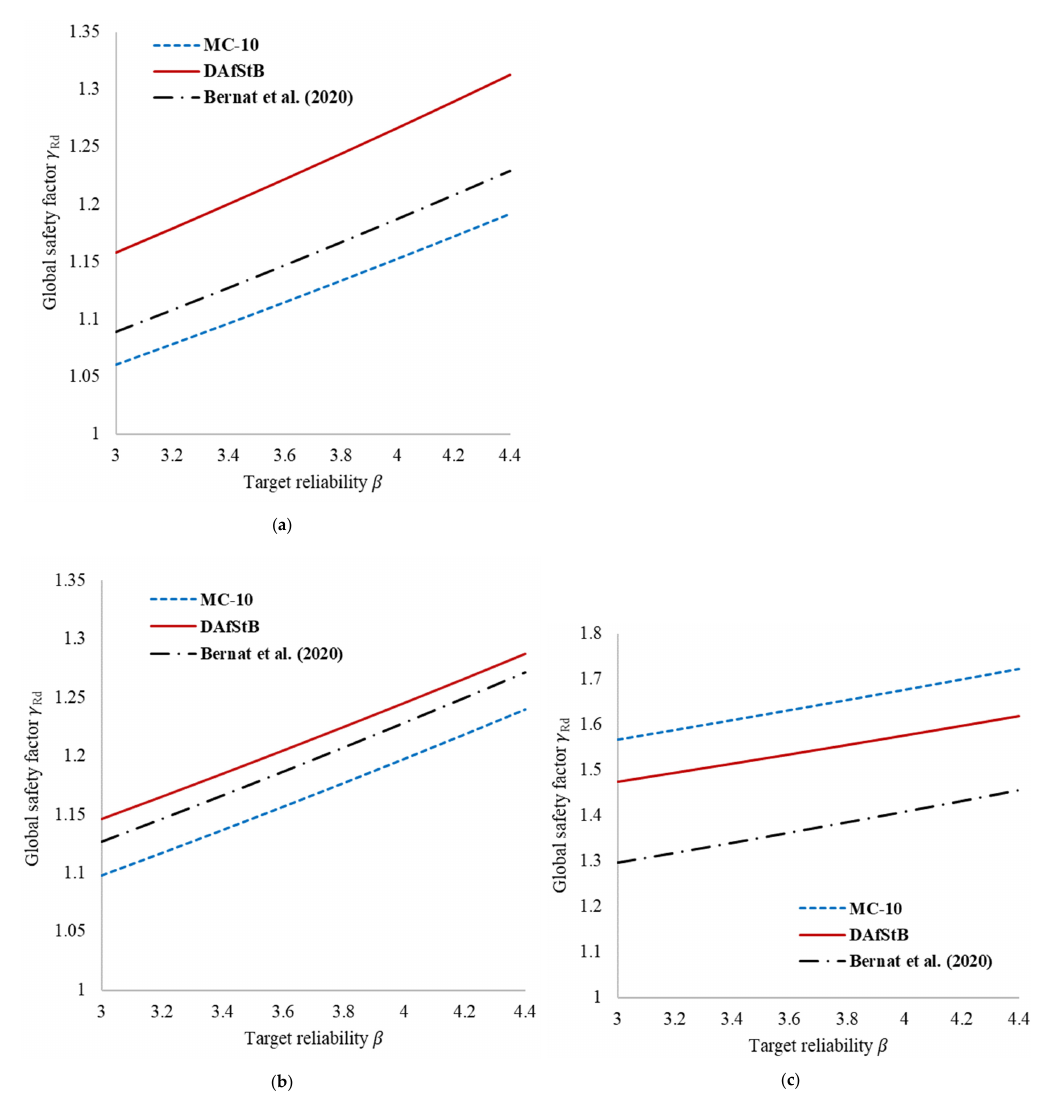
Figure 7. Variation of the partial factor γ Rd with β (using the statistics of the full database).